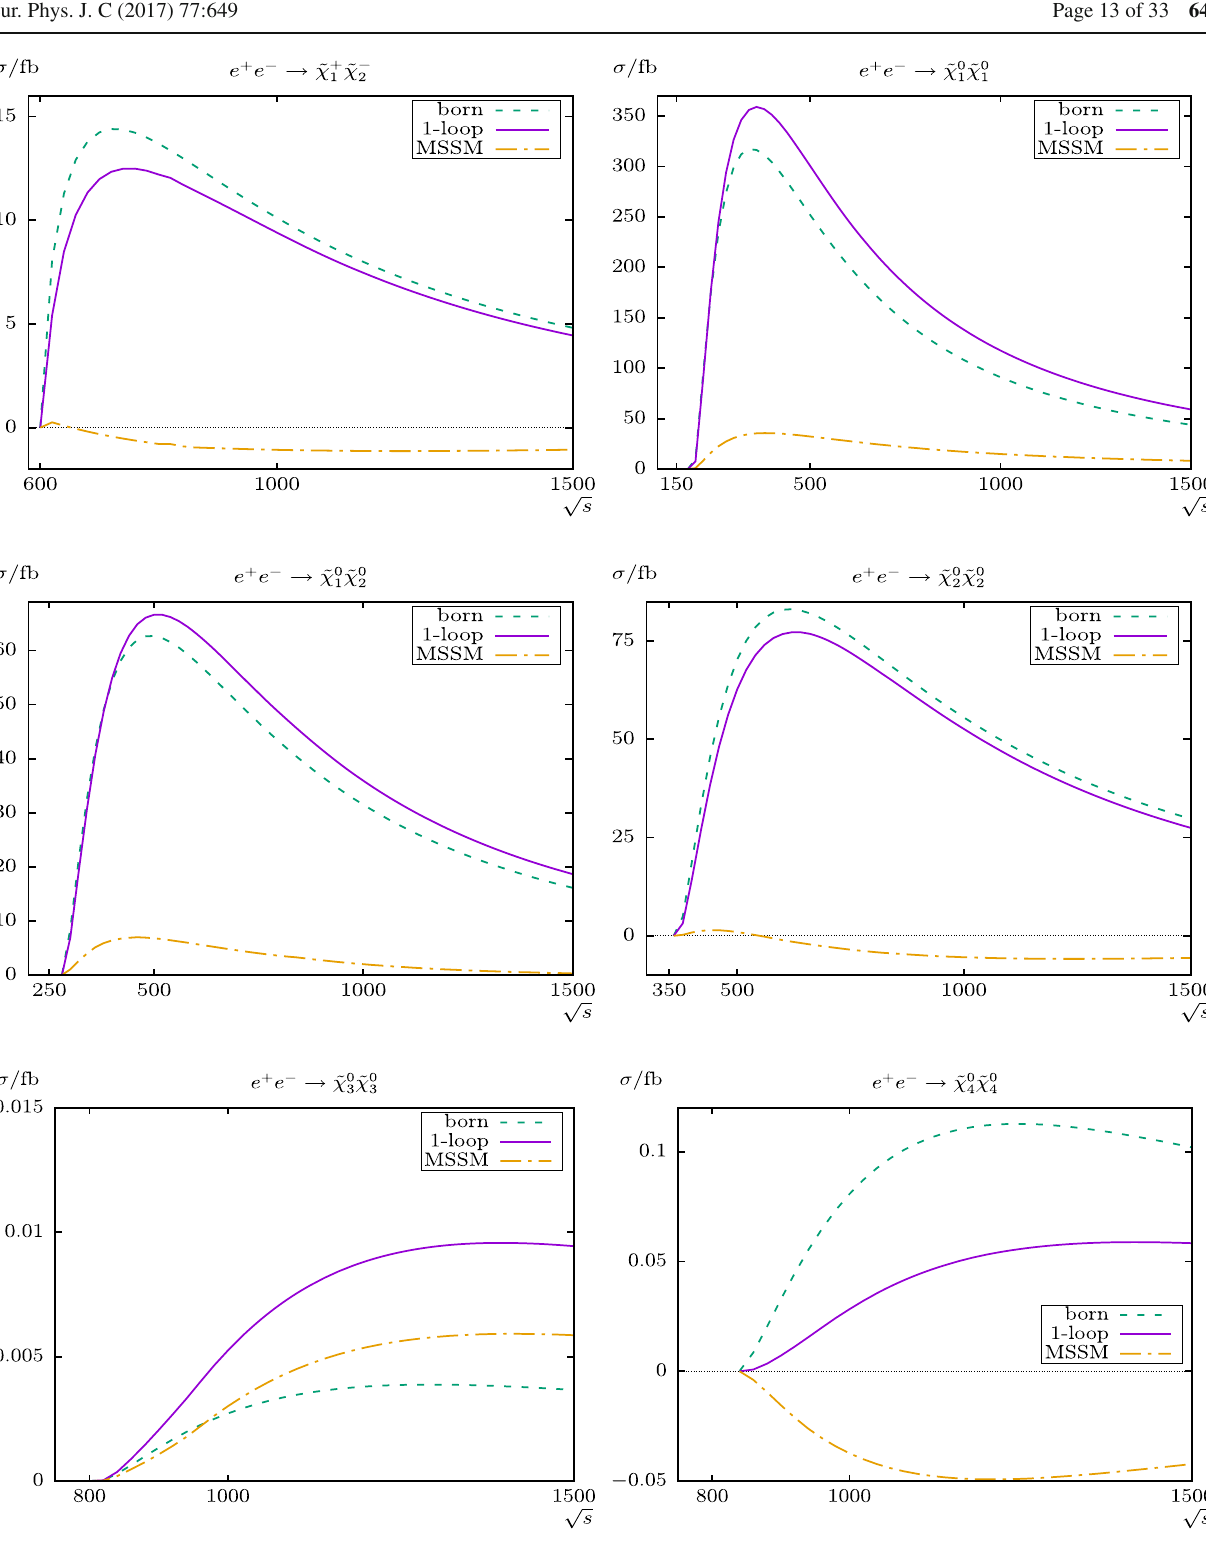
Fig. 12 Comparison with Ref. [50] for σ( e + e − → ˜ χ ± c ˜ χ ∓ the on-shell parameter set SPS1 a (cid:4) chosen according to Ref. [50], varied with